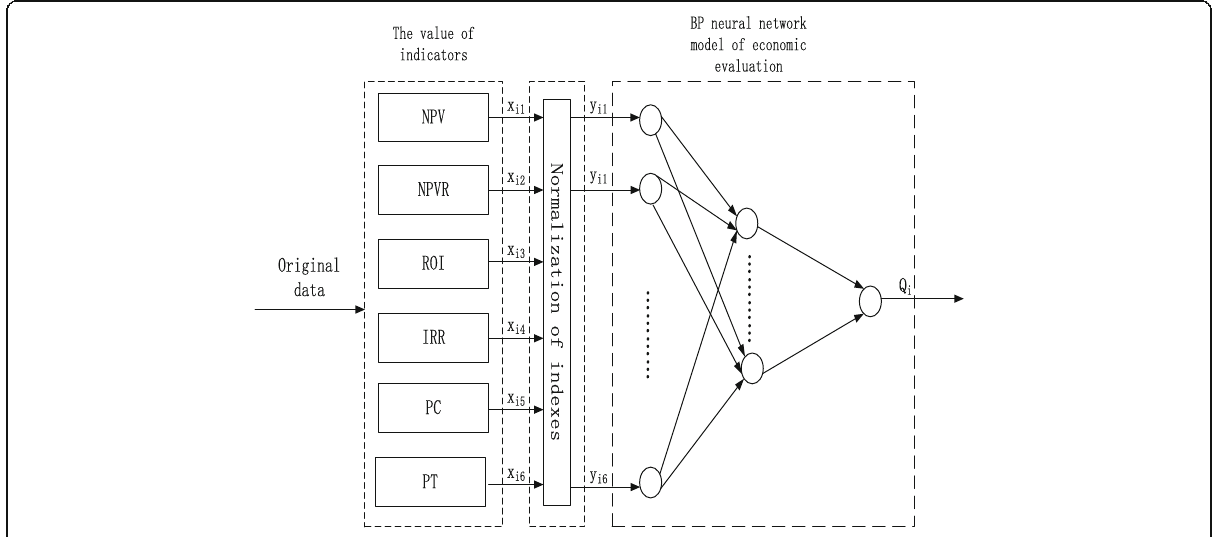
Fig. 4 The process of economic evaluation based on BP neural network